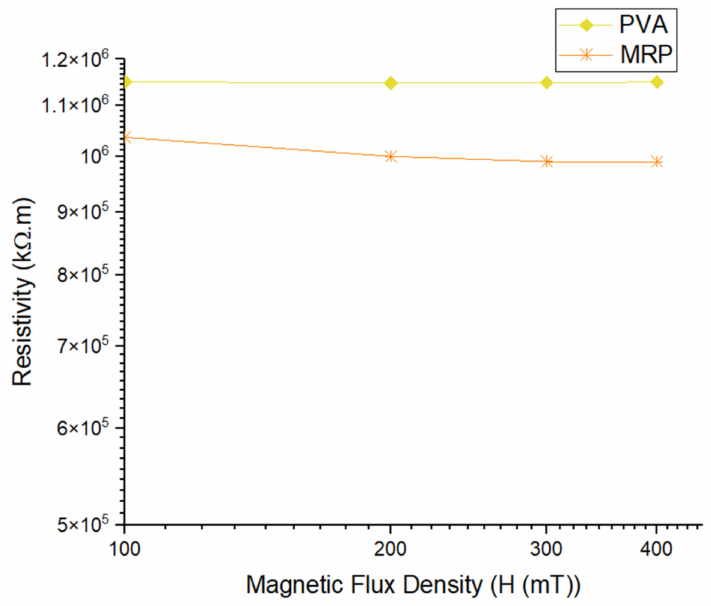
Figure 6. Resistivity of PVA and MRP under different magnetic flux densities.